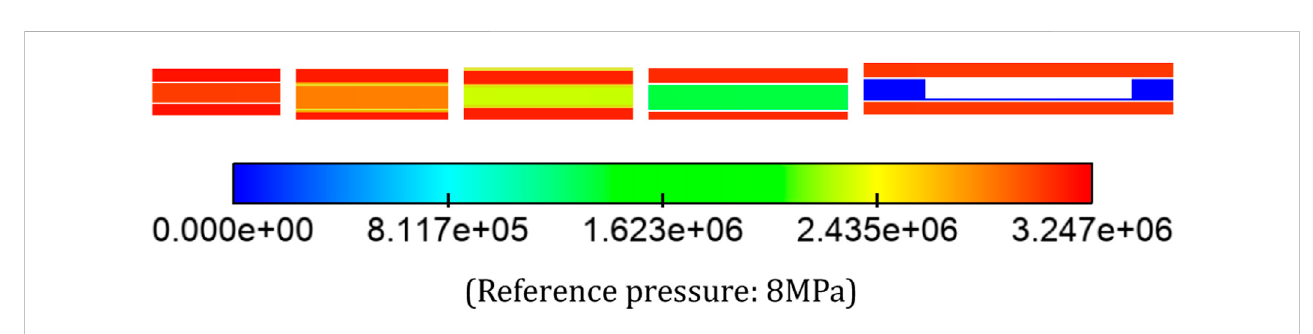
FIGURE 12 Pressure fi eld in wellbore (9.1 s).